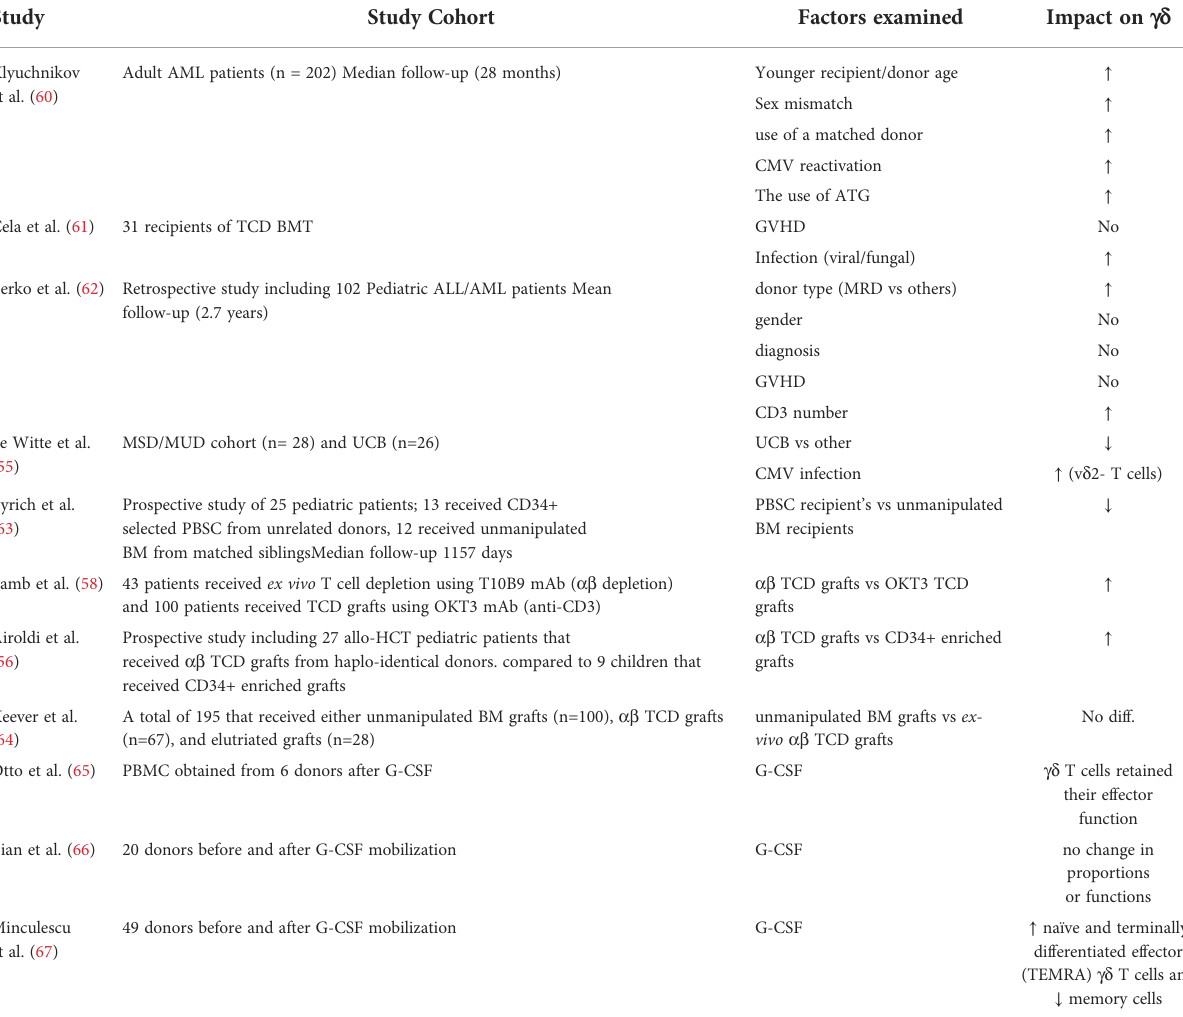
TABLE 1 Factors affecting gd T cell